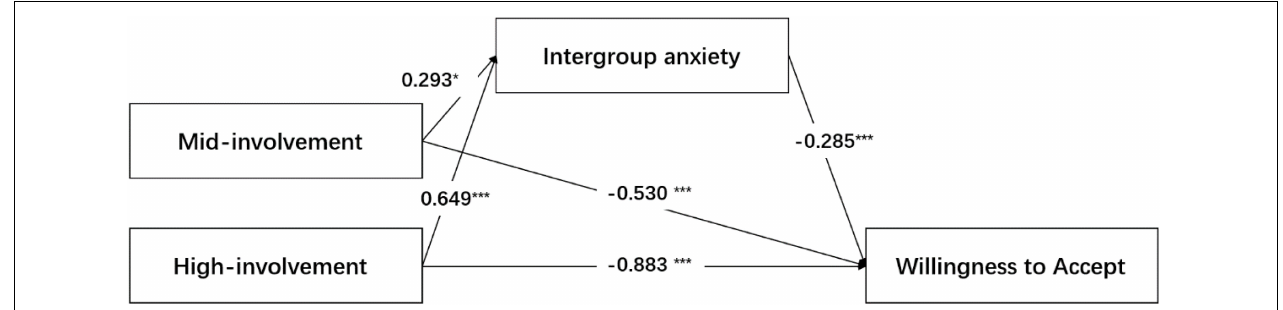
FIGURE 2 | The result of experiment 2. * p < 0.05, *** p <